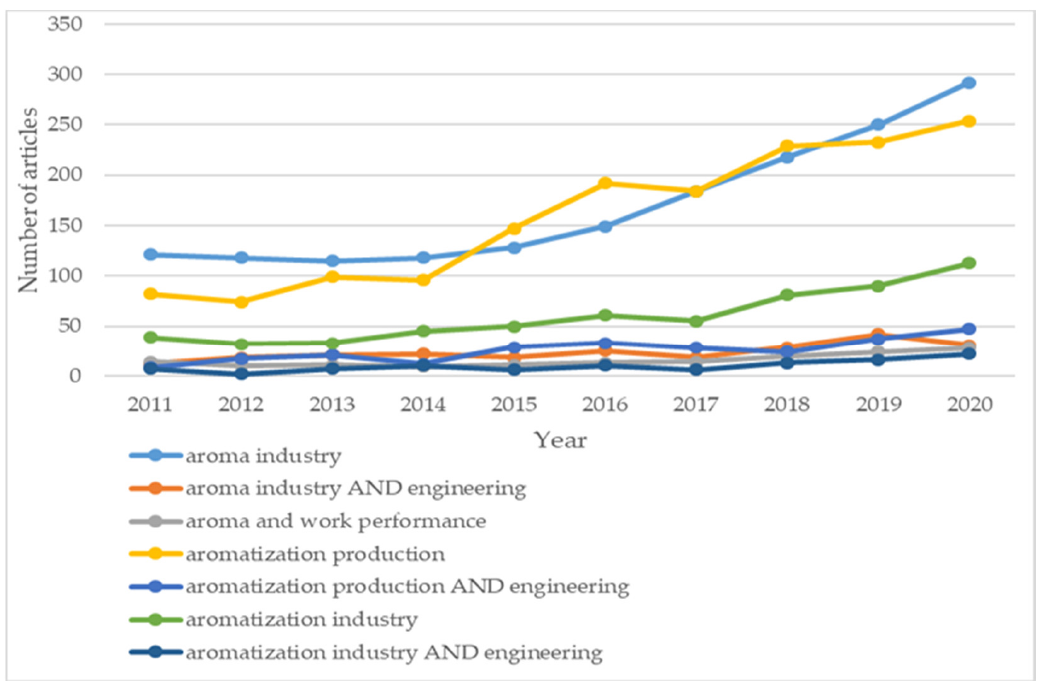
Figure 5. Number of publications per years.